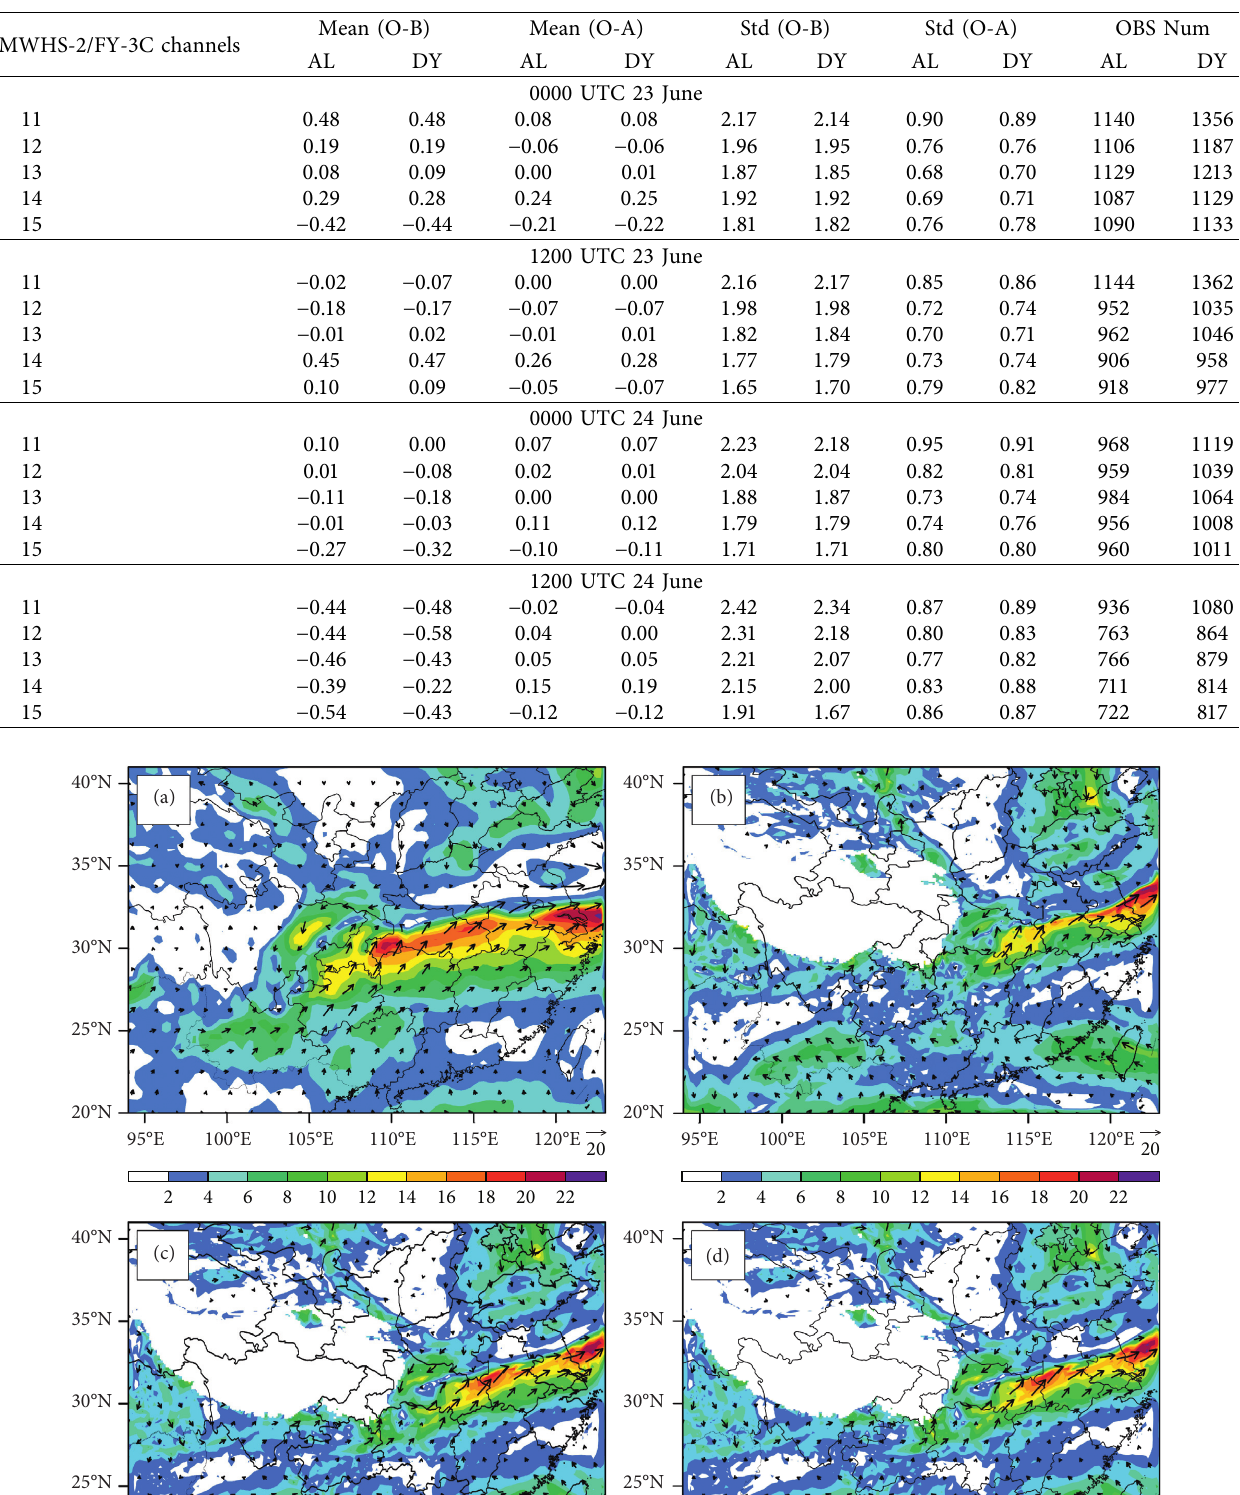
Table 5: The mean and standard deviation of O-B and O-A and the number of assimilated observations for channels 11–15 in the AL and DY experiments at each analysis time.